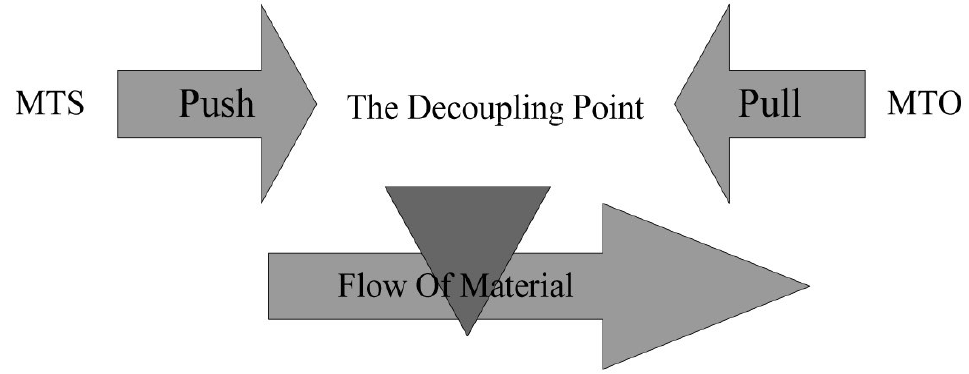
Figure 1. feasible positions of a decoupling